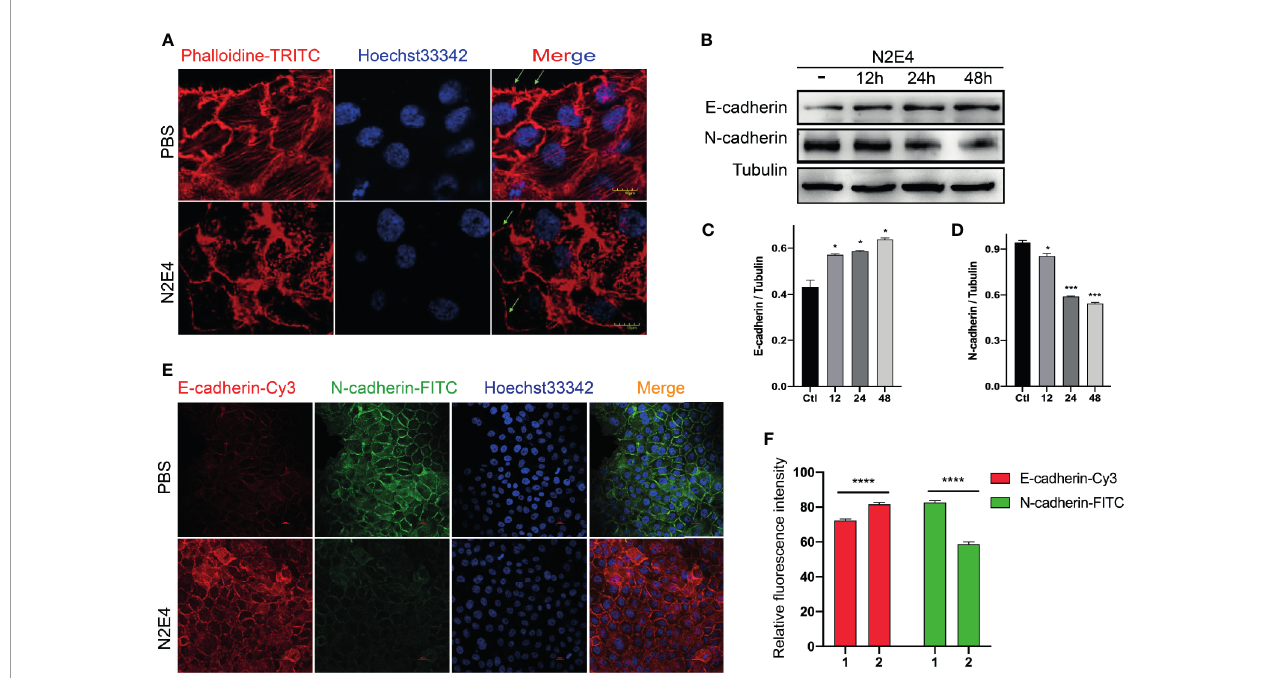
FIGURE 4 | The formation of pseudopods and the expression of E-cadherin/N-cadherin in BxPC-3 cells. (A) Phalloidine staining in BxPC-3 with the treatment of PBS or N2E4. Note the intense staining at the leading edge of invasive pseudopod protrusions, marked by arrows. Scale bars=10µm. (B) The protein levels of E- cadherin and N-cadherin with 12, 24, or 48 h pre-incubation using N2E4 or PBS (-) as measured by western blotting analysis. Densitometric analysis on the levels of (C) E-cadherin and (D) N-cadherin were normalized against the corresponding tubulin protein levels, which was then designated as 1. Bars are the means±SD, n=3. * P <0.05; *** P <0.001. (E) After pre-incubation using N2E4 or PBS for 48 h, E-cadherin (Cy3, red) and N-cadherin (FITC, green) were measured by immuno fl uorescence analysis. (F) Relative fl uorescence intensity of E-cadherin-Cy3 and N-cadherin-FITC was represented. Bars are the means±SD, n=3. **** P